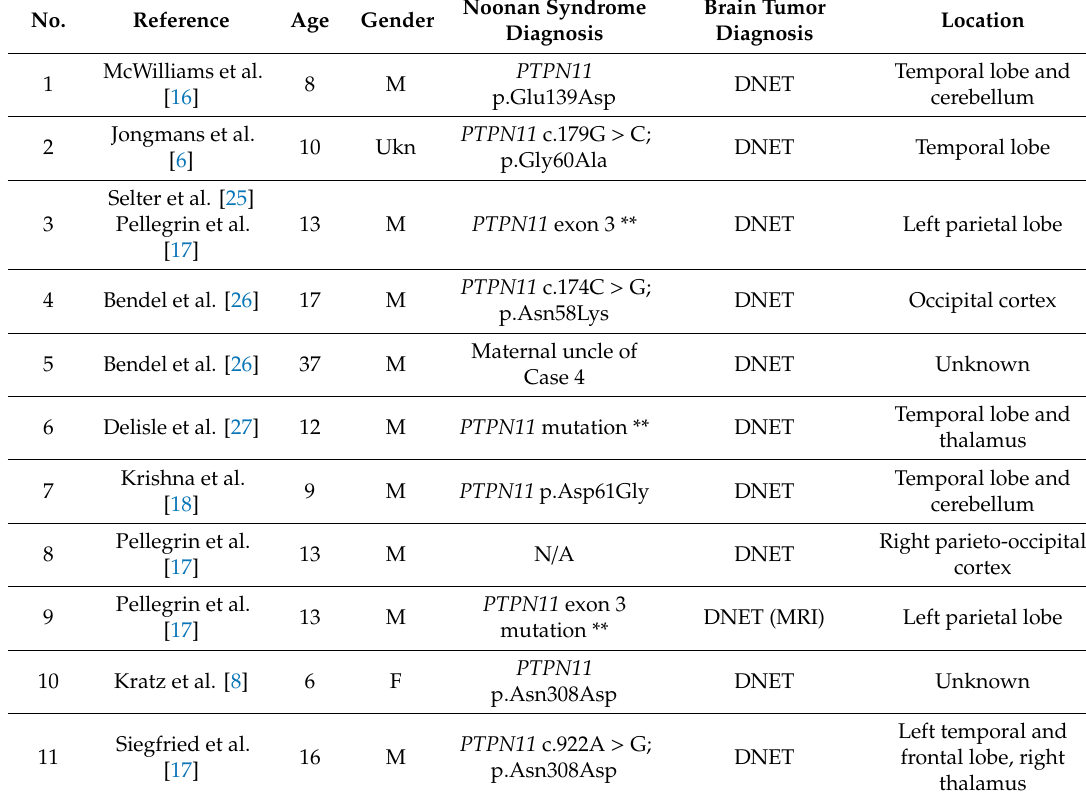
Table 1. Primary brain tumors reported in Noonan